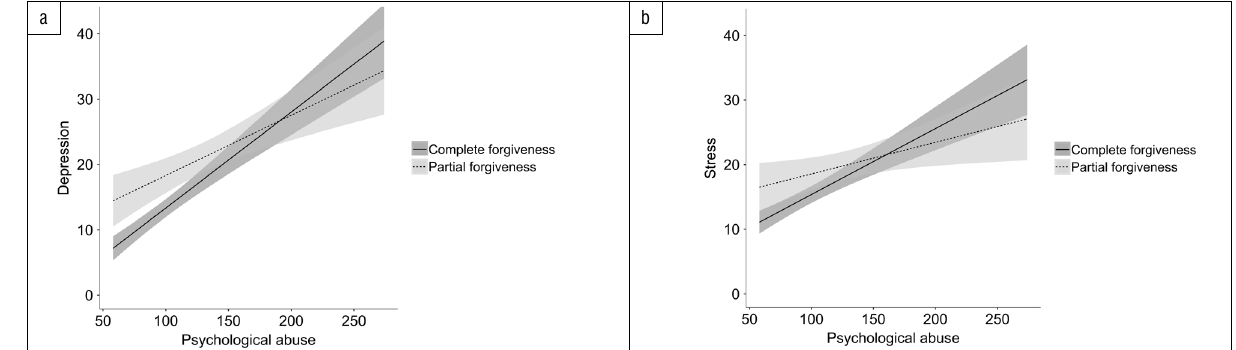
Figure 2: Relations of psychological abuse with (a) depression and (b) stress are moderated by forgiveness of partner. Table 3: Summary statistics for multiple regression analyses